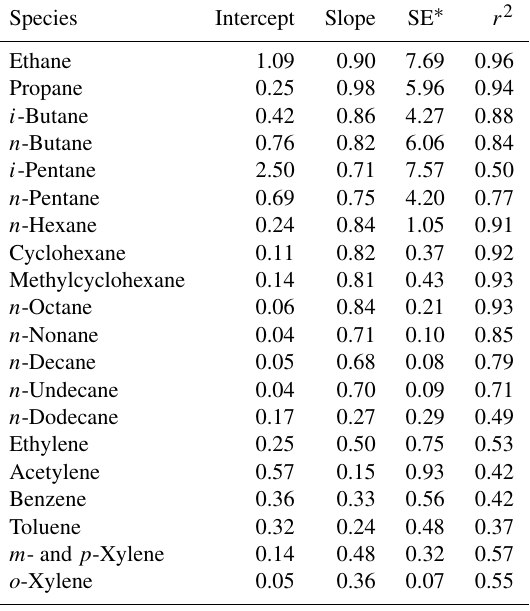
Table A1. Pearson coefficients between the observed and predicted VOC concentrations for the five-factor solution.